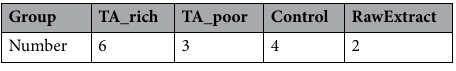
Table 1. The number of samples in each group.